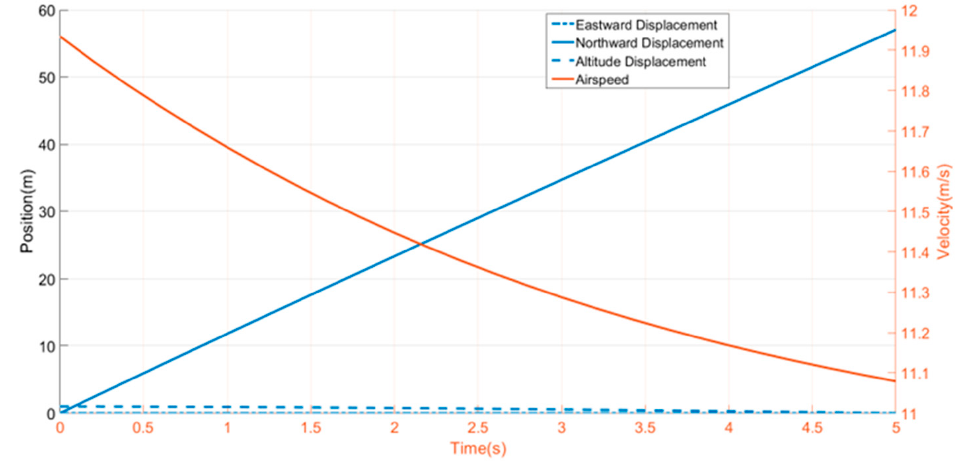
Figure 7. The detailed results for the trajectory and airspeed.